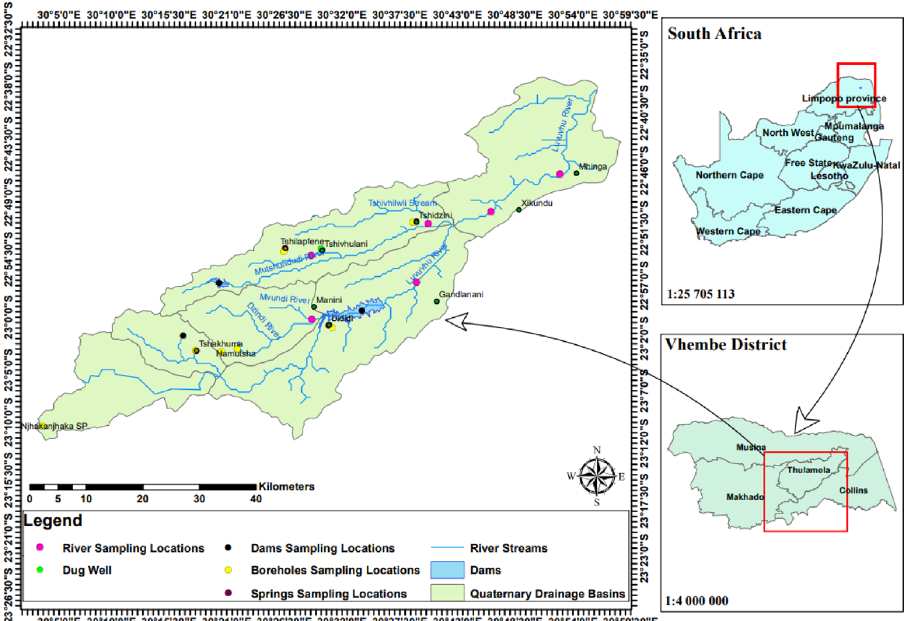
Figure 4. Map showing study area. Vhembe District Municipality is located in the northern part of Limpopo Province in South